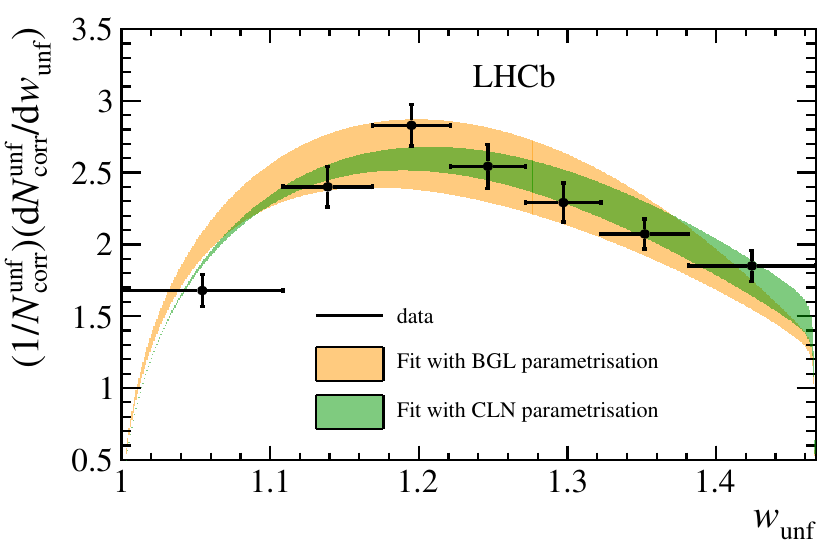
Figure 5 . ∆ χ 2 contours for the scaled parameters a f the best-fit central value. The solid (dashed) contour encloses the ∆ χ 2 = 2.3 (6.17) region. The observed shape is due to the applied unitarity condition, see eq. (2.11).